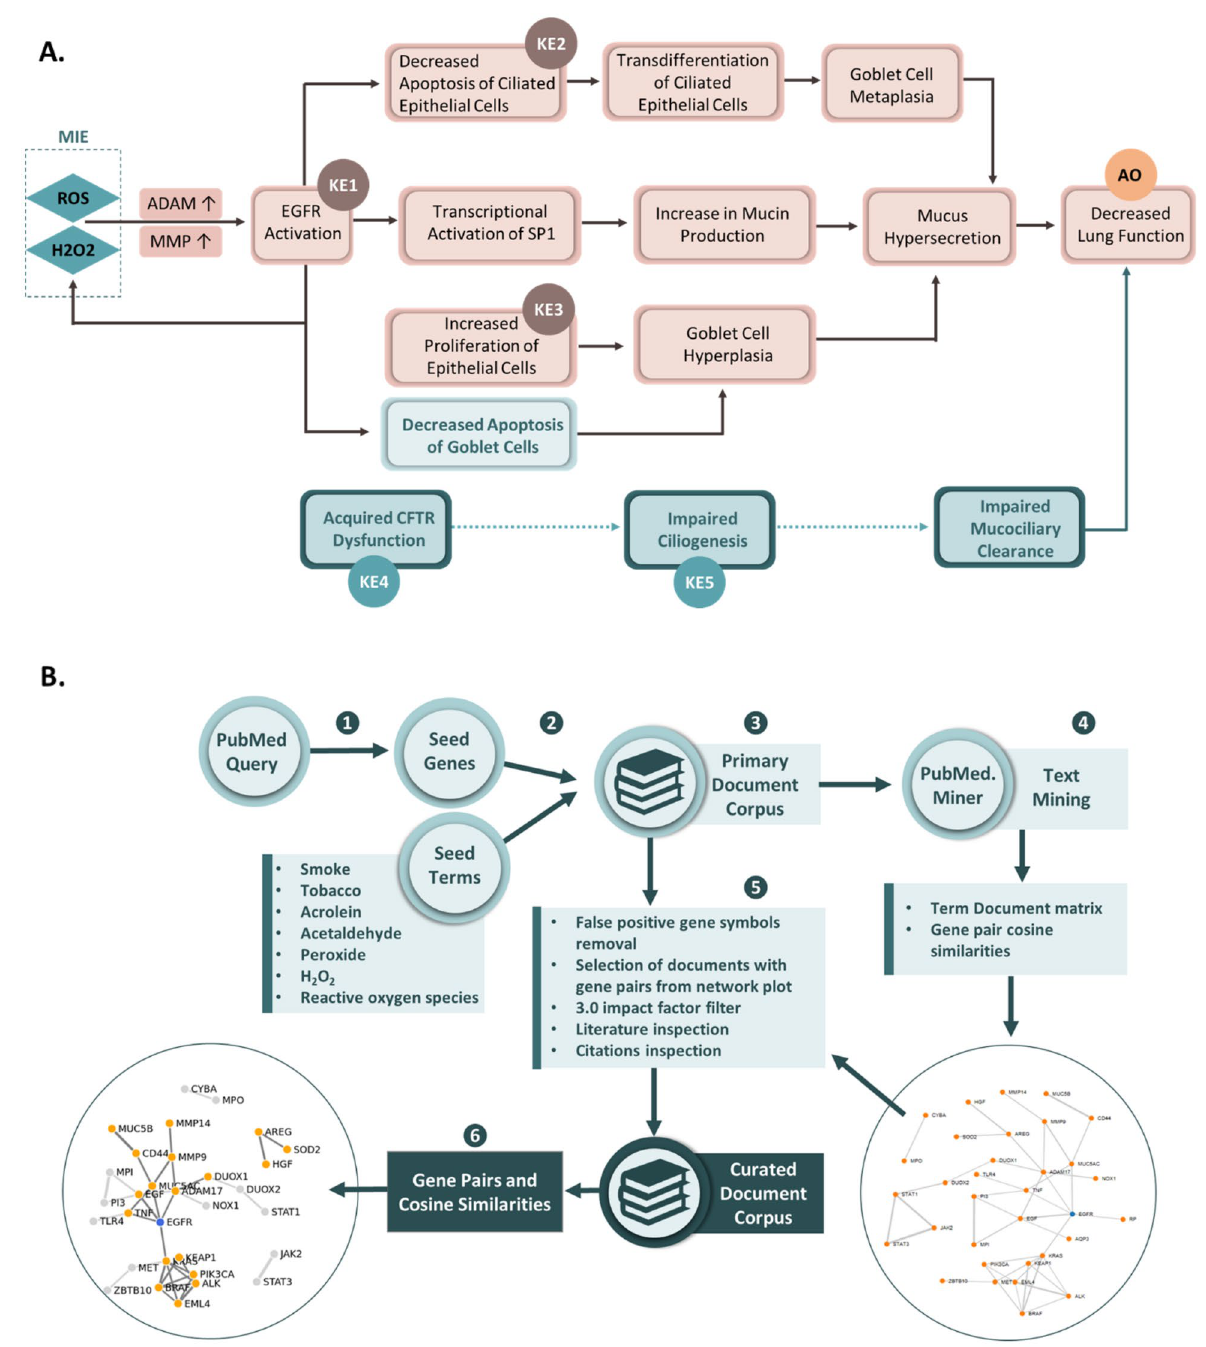
Figure 1. ( A ) Mucus hypersecretion AOP and impaired mucocilliary clearance key events (AOP 148). ( B ) Text mining process. 1. A manual search was first conducted using KE terms to derive seed genes. 2. Pubmed was searched using a combination of seed genes and tobacco related key terms. 3. The resulting primary document corpus was then mined for gene symbols (4) 4. Gene pairs were used to construct network plots. 5. Gene pairs from articles with an impact factor equal or higher than 3.0 were retained together with the corresponding publication. Further manual searches were conducted to include the most recent literature. 6. Gene network plots and KE genesets were finalized based on the curated document